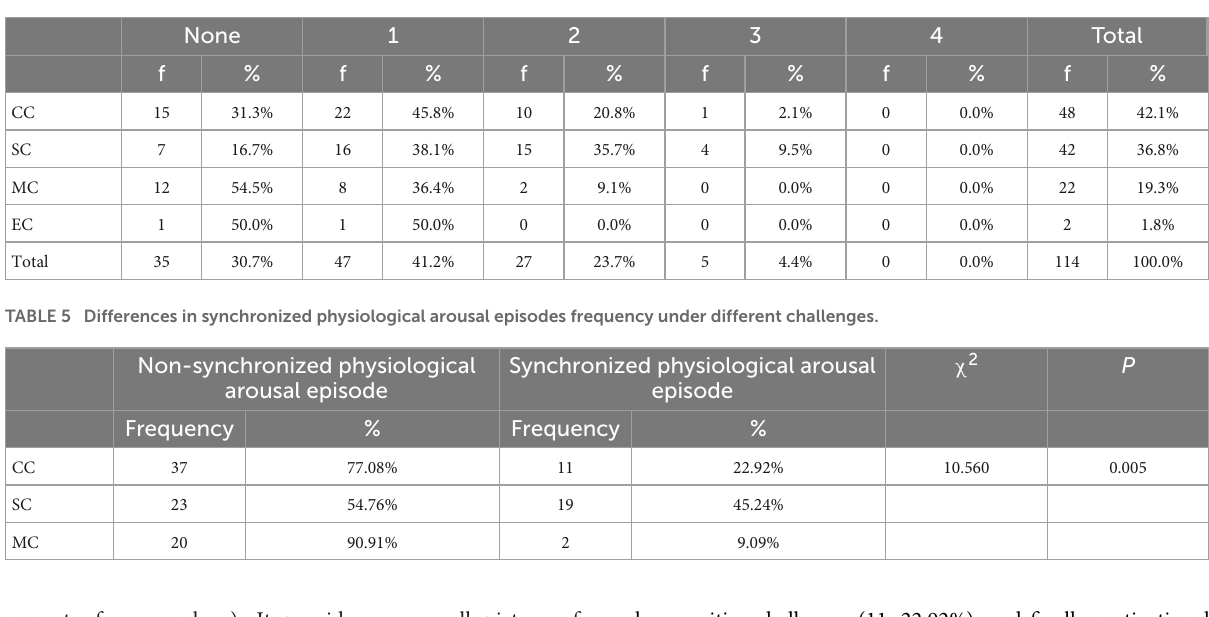
TABLE 4 Frequency and percentage of challenges episodes with different arousal numbers (from none to four members).